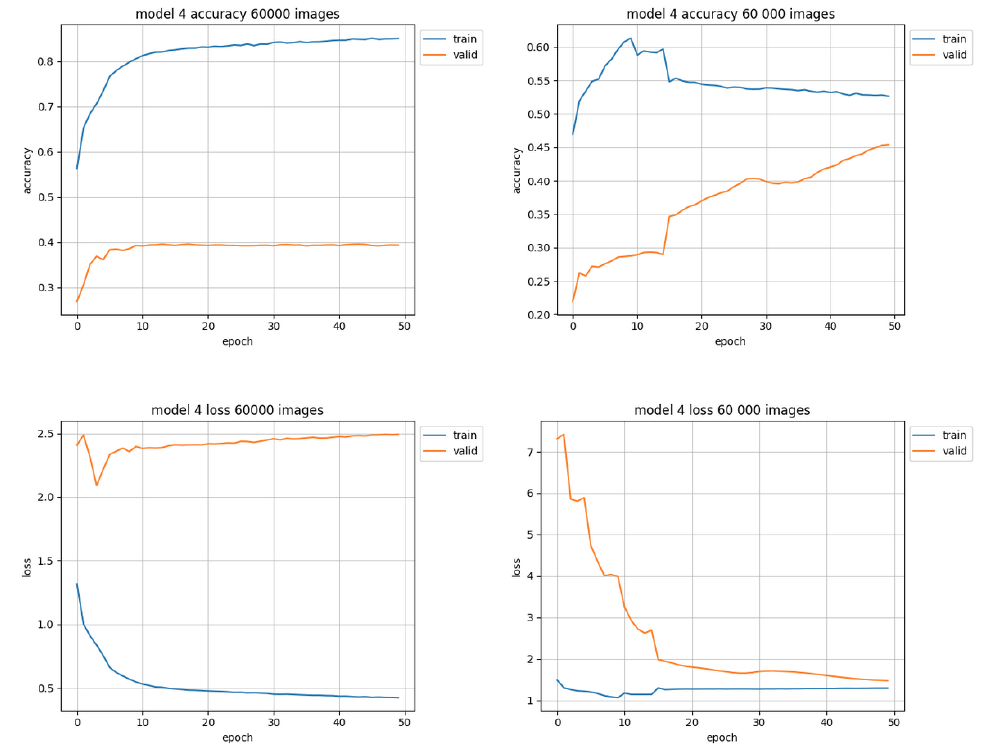
Figure 10. Training results using 60,000 images. Charts on the left side of figure present results using natural data distribution, charts on the right side show results using trimmed data